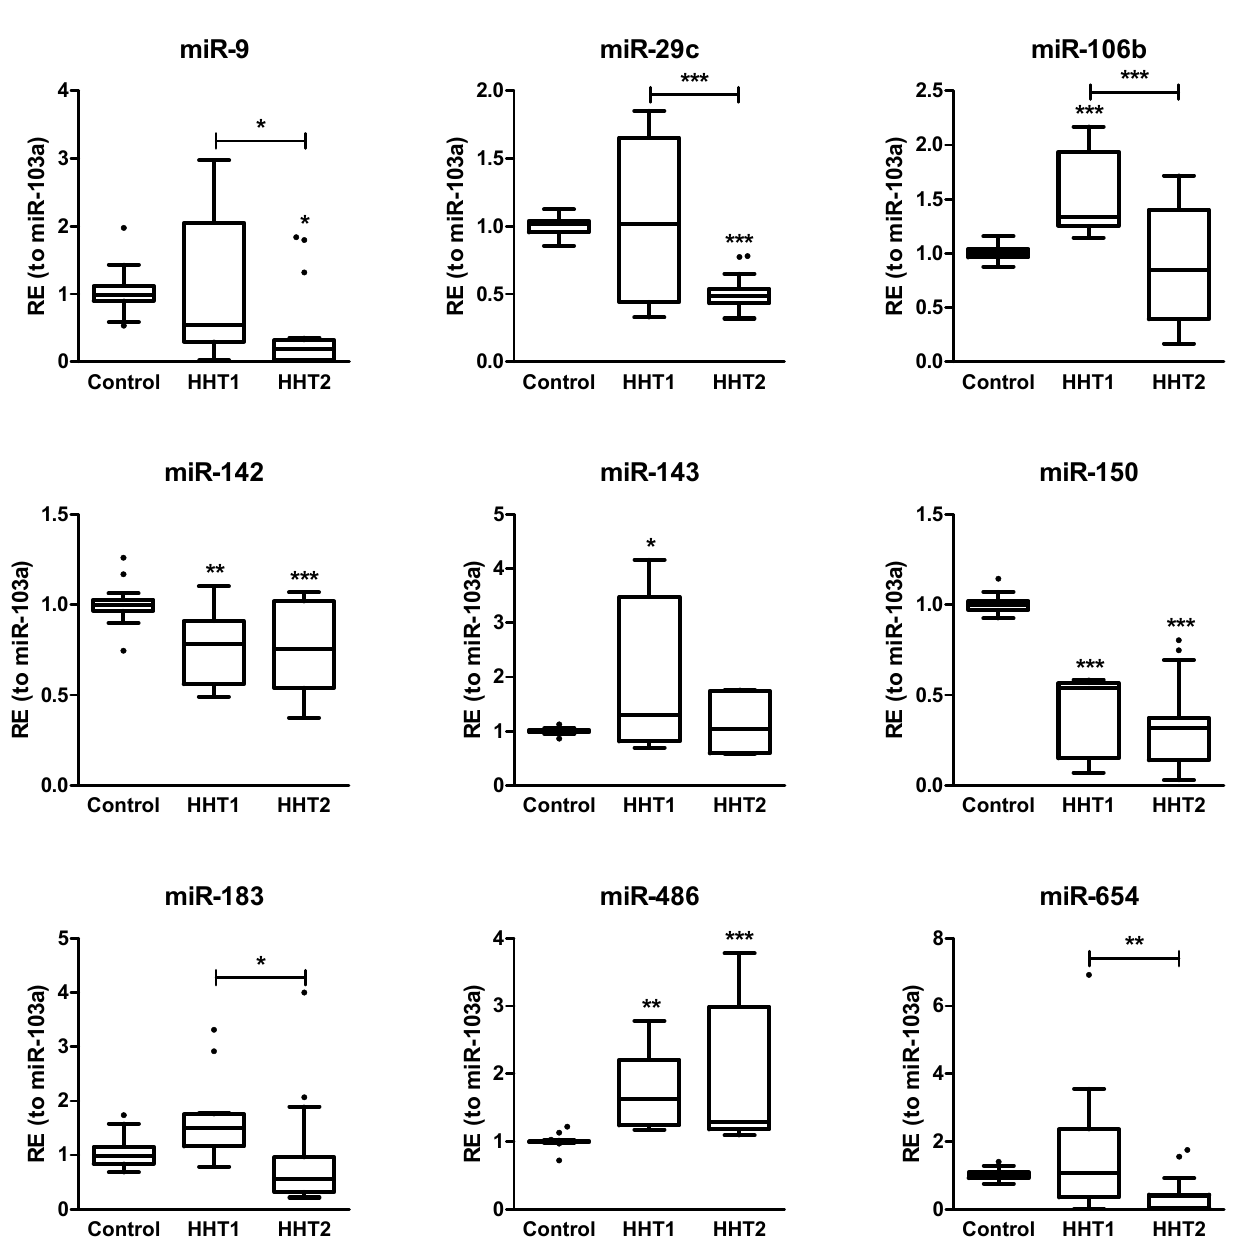
Figure 4. Validation of the miRNA signature of HHT. The relative expression (RE) of 9 miRNAs was assayed by real-time PCR in a cohort of 7 donors per group. The comparison with the control group was carried out by the analysis of variance test (ANOVA) with the Bonferroni correction (* p < 0.05; ** p < 0.01; *** p < 0.005). Tukey’s method was applied to identify outliers (black dots) in the box-plots.